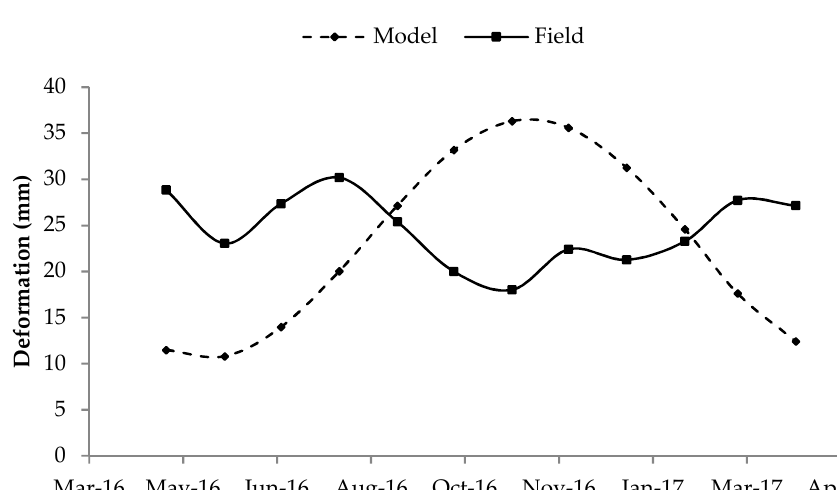
Figure 15. Comparison of model and field results with seasonal effects.